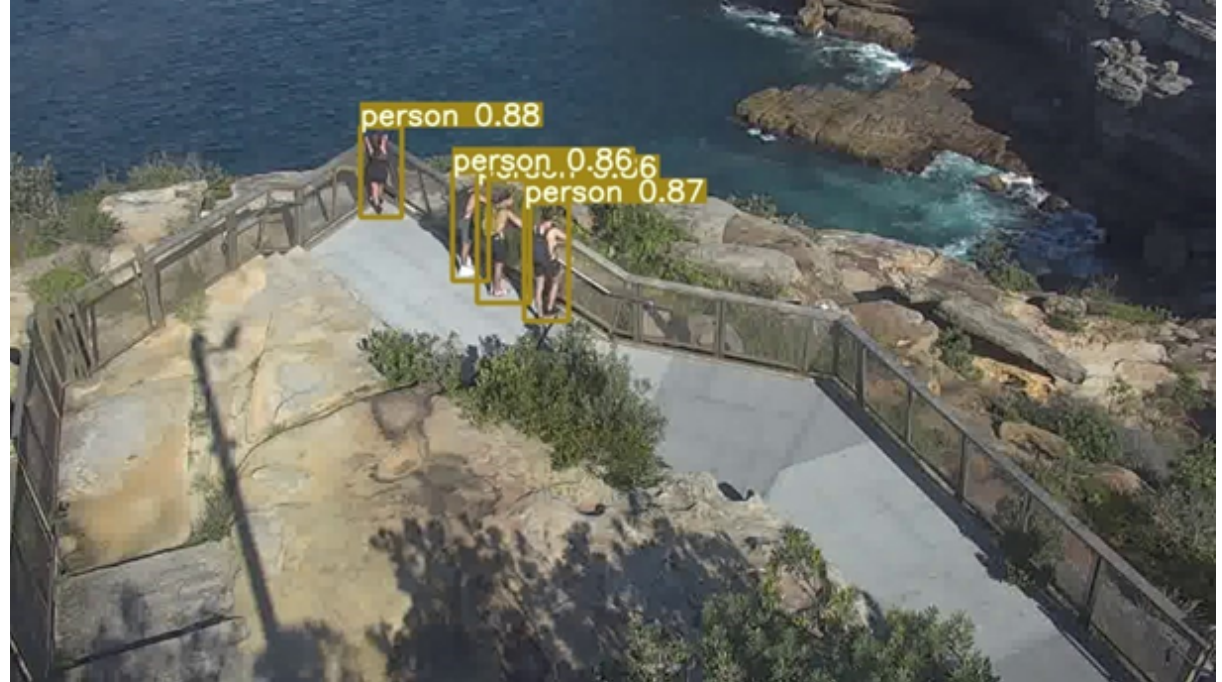
Figure 4. Pedestrian Detection Output using the Fine-tuned Algorithm. All four pedestrians were identified, and with high confidence